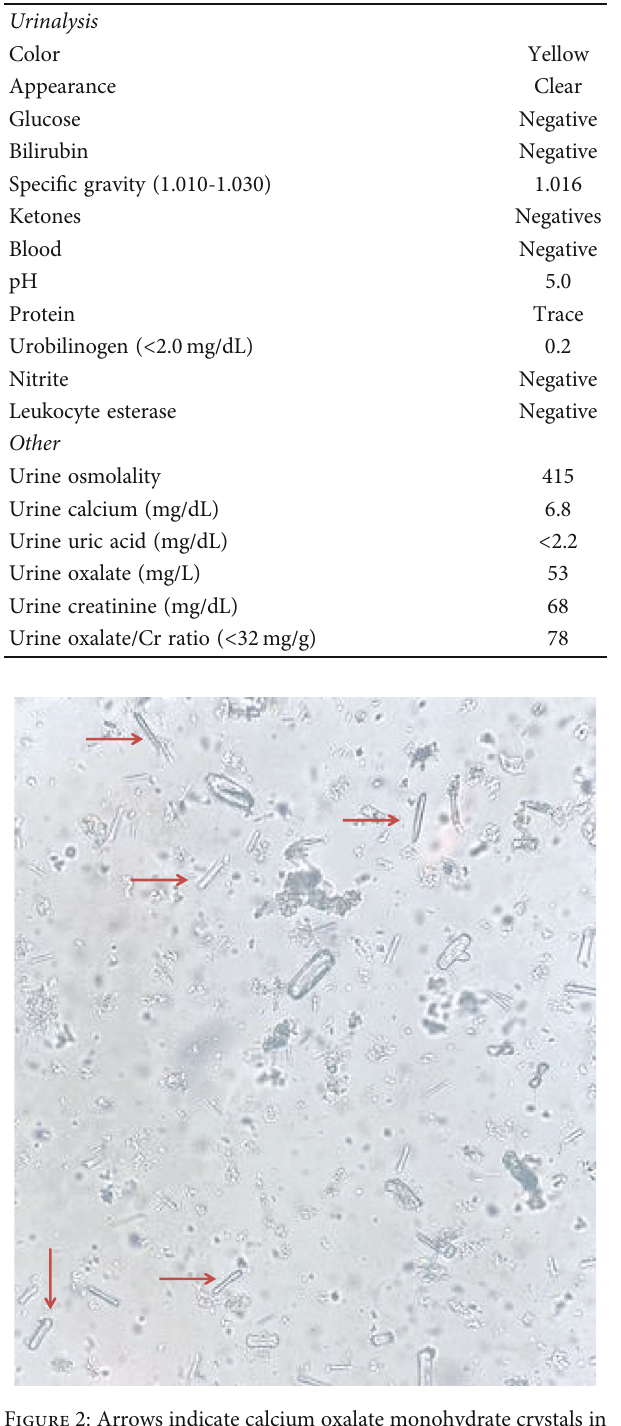
Table 3: Ethylene glycol